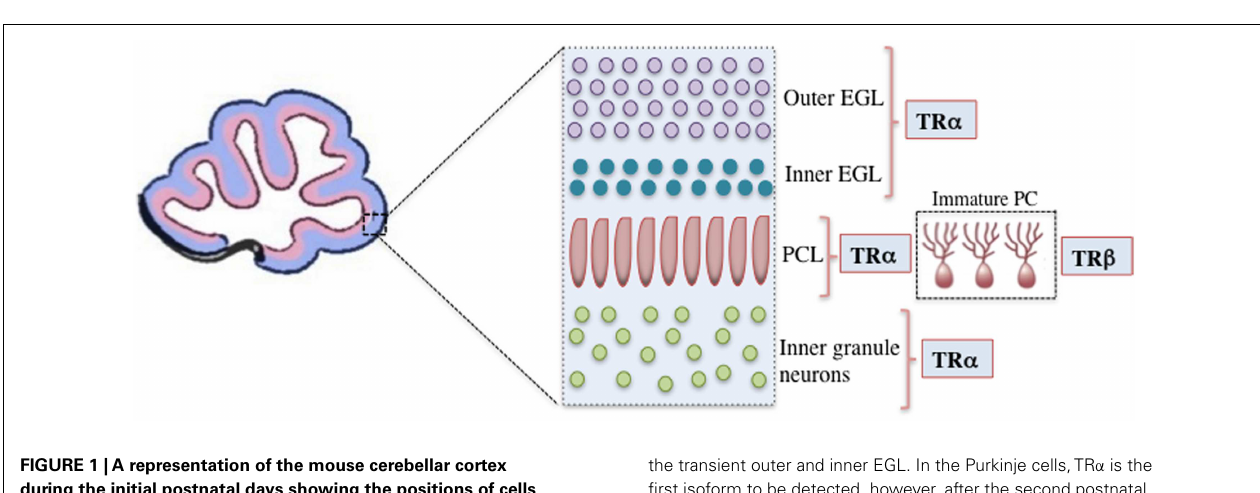
FIGURE 1 |A representation of the mouse cerebellar cortex during the initial postnatal days showing the positions of cells expressing specificTR isoforms . Only the outer EGL, inner EGL, Purkinje cell layer (PCL), and inner granule layer are shown.TR α is primarily expressed in granular cell precursors and subsequently in